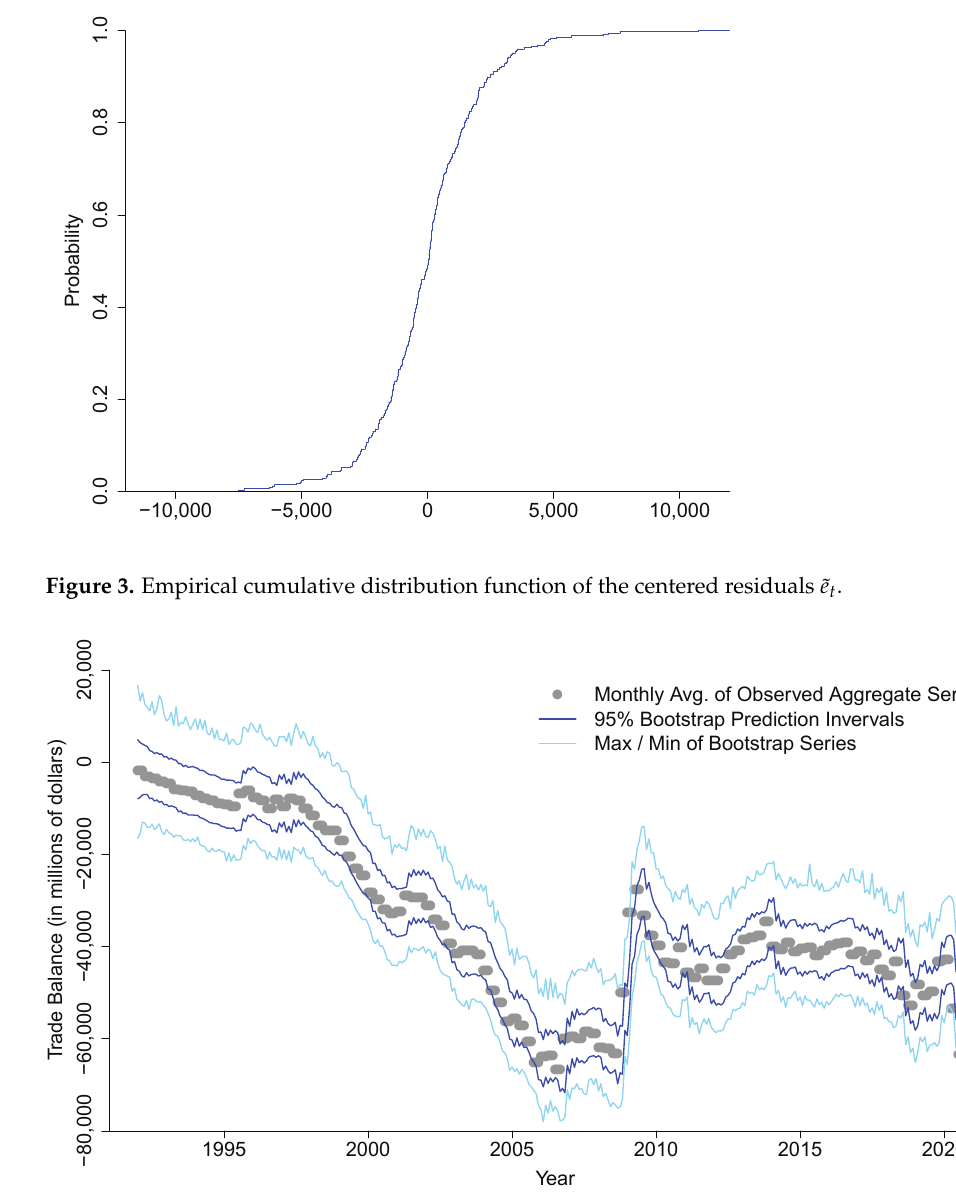
Figure 4. Bootstrap prediction intervals for the unknown monthly series x t